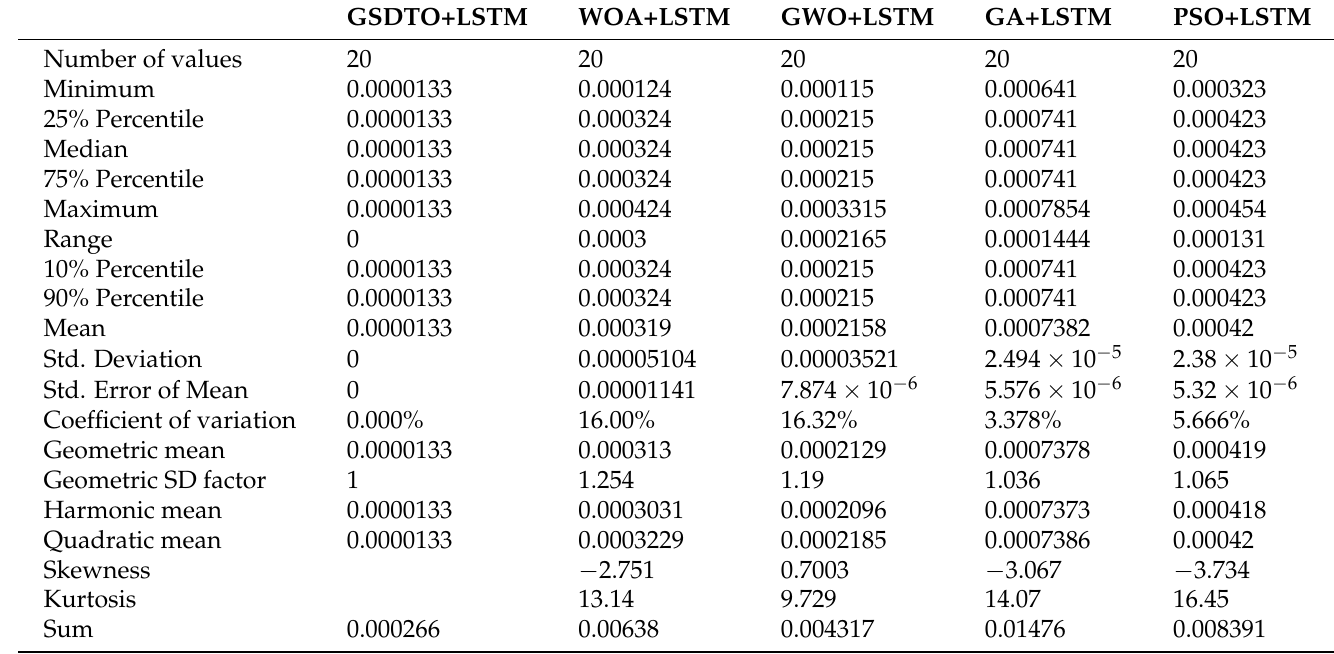
Table 12. Proposed and compared classifiers description.